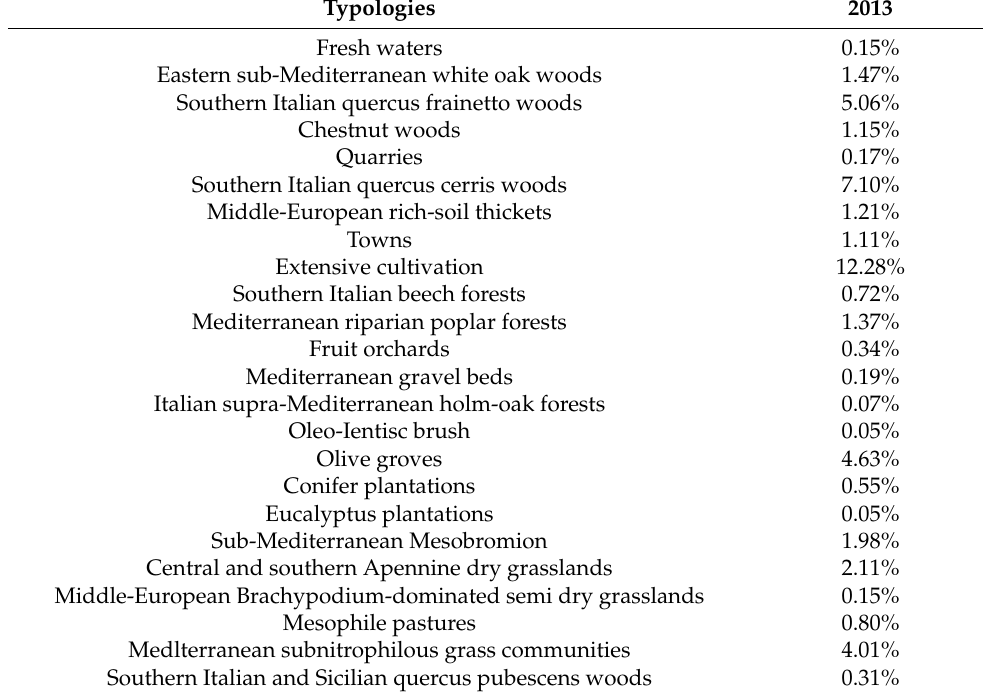
Table 2. Percentages of Corine Biotopes habitats in 2013 calculated in the area of the Lucanian Ofanto